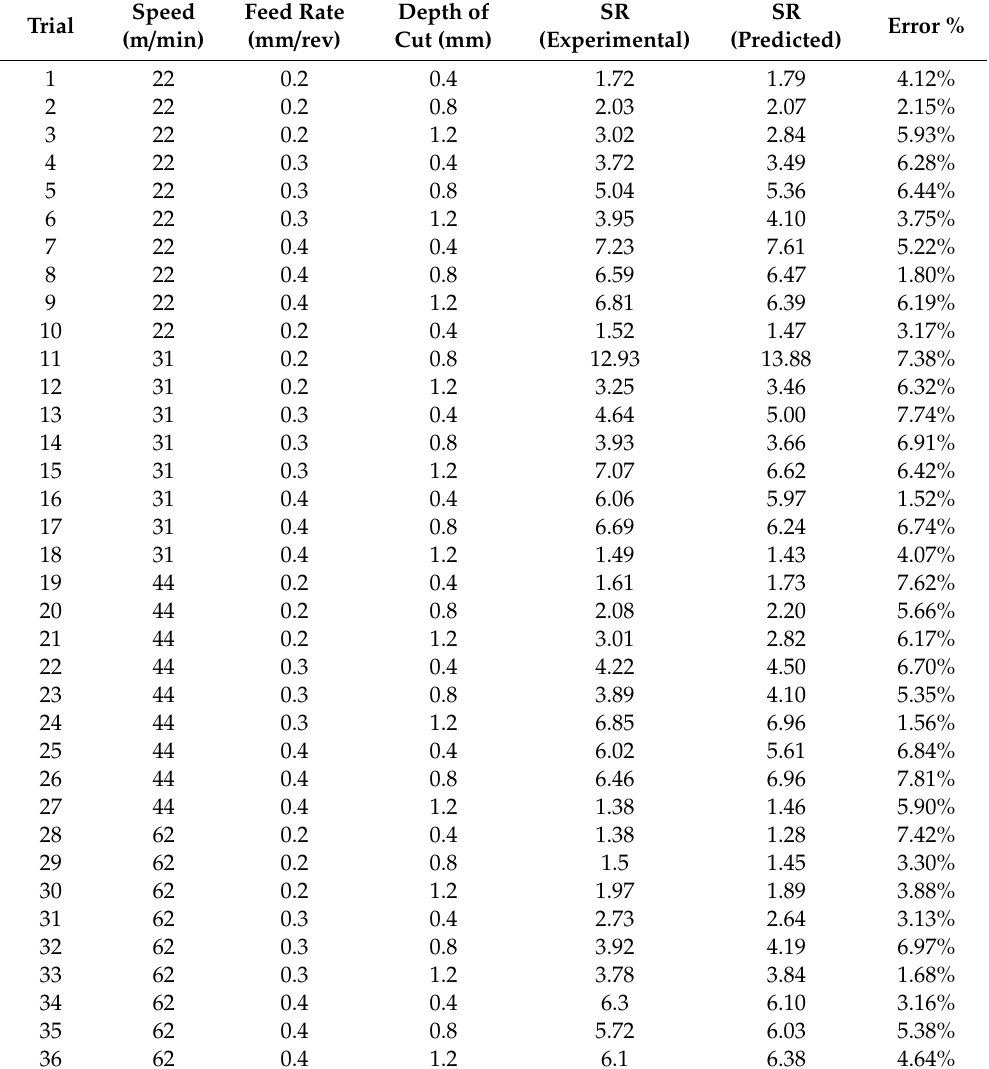
Table 9. ANFIS-QPSO prediction results of the surface roughness values for a cryogenic turning process.